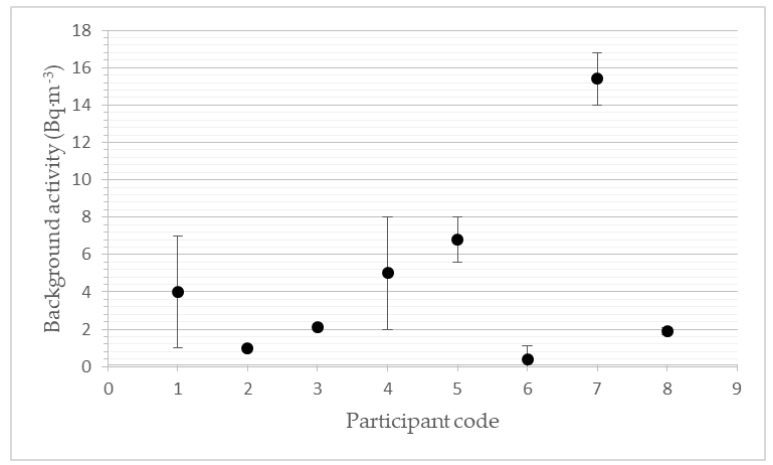
Figure 1. Results of participants’ devices in a zero-radon-activity concentration atmosphere.